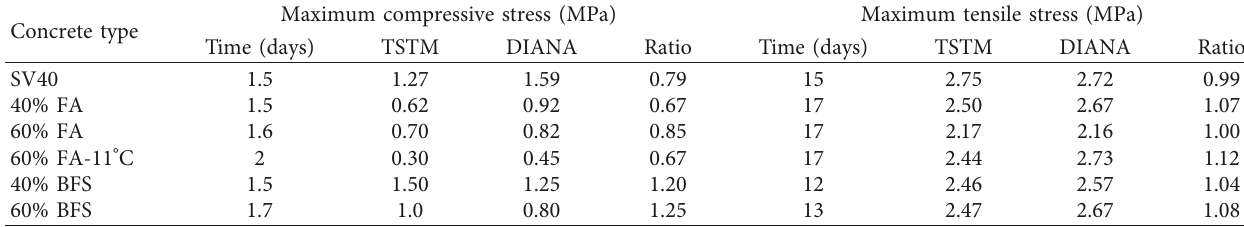
Table 6: Calculated and measured stresses in the TSTM tests.